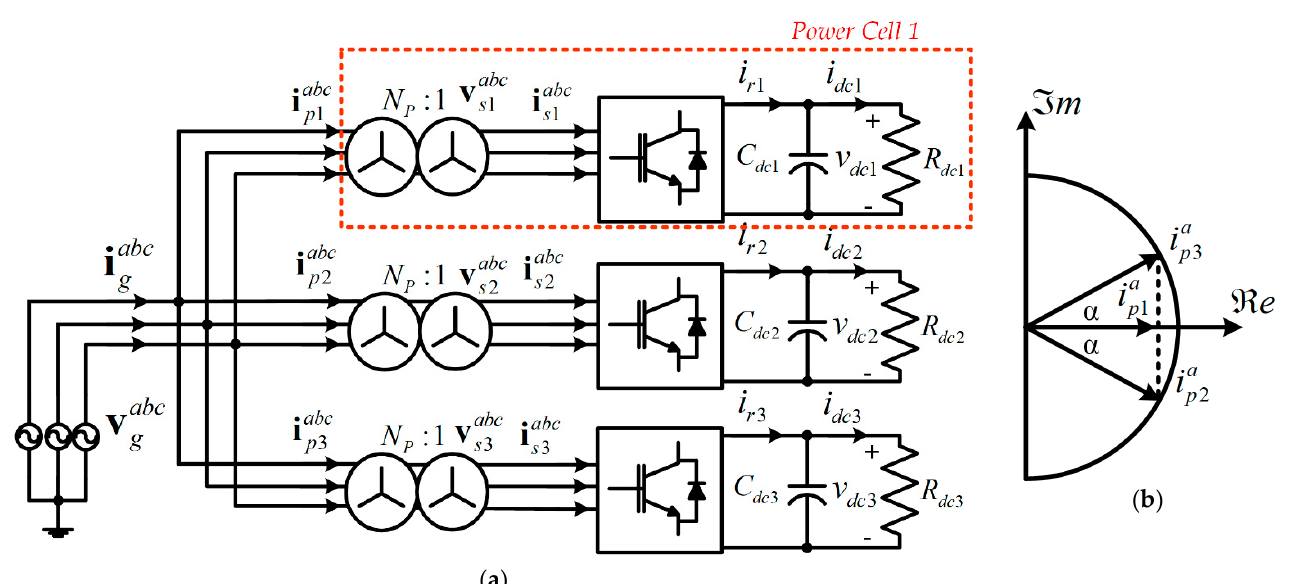
Figure 1. Topology and vector diagram input current power cells. ( a ) Multicell AFE rectifier, ( b ) phasor diagram of input currents of power cells.